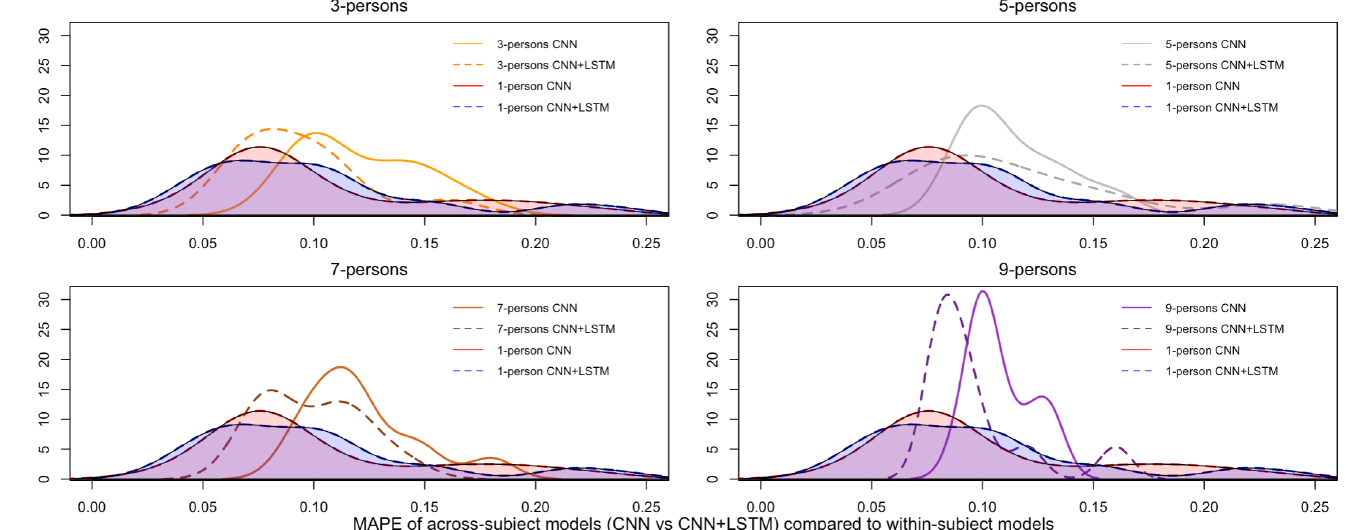
Figure 12. Pairwise comparisons of the test Mean Absolute Percentage Error (MAPE) of the across- subject models trained, respectively, with the single convolutional neural network (CNN) and the convolutional/recurrent neural network (CNN+LSTM) compared to the within-subject